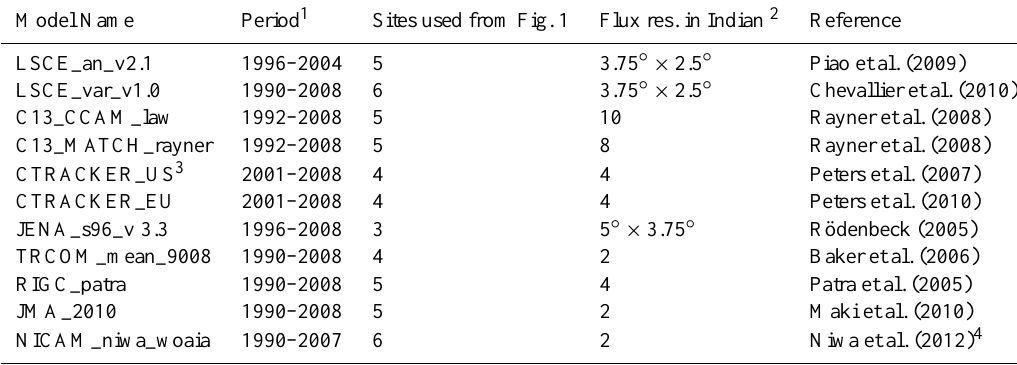
Table 2. The atmospheric inversions and periods over which data were evaluated in this study.